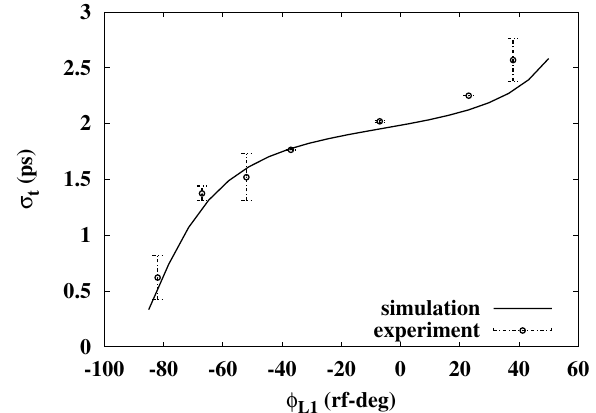
FIG. 5. rms bunch length versus phase of the linac section L1.